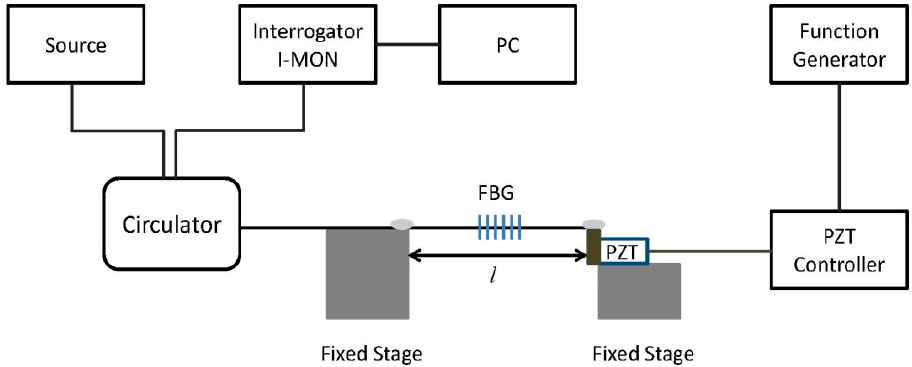
Figure 8. Schematic of experimental set-up for dynamic strain characterization. PZT: piezo electric transducer. PC: personal computer.